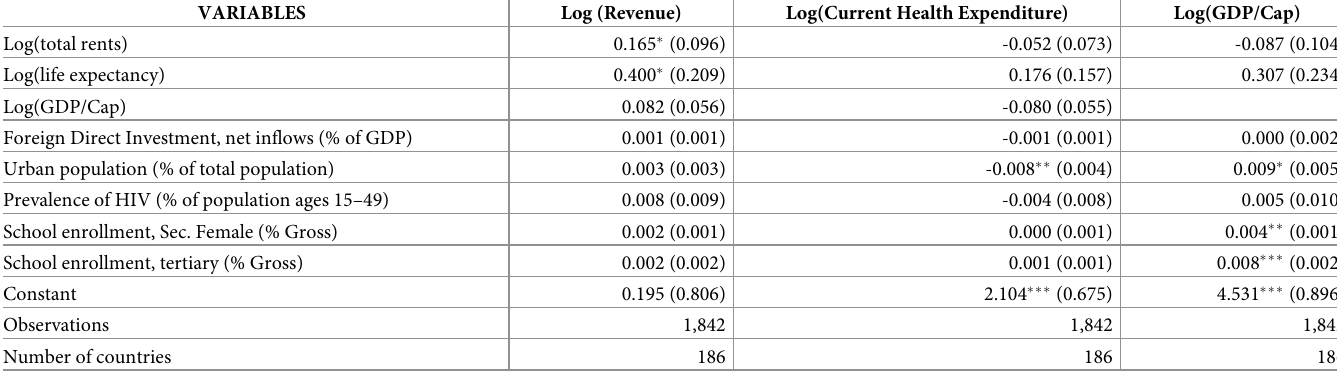
Table 5. Relationship between resource rents and government revenue and health